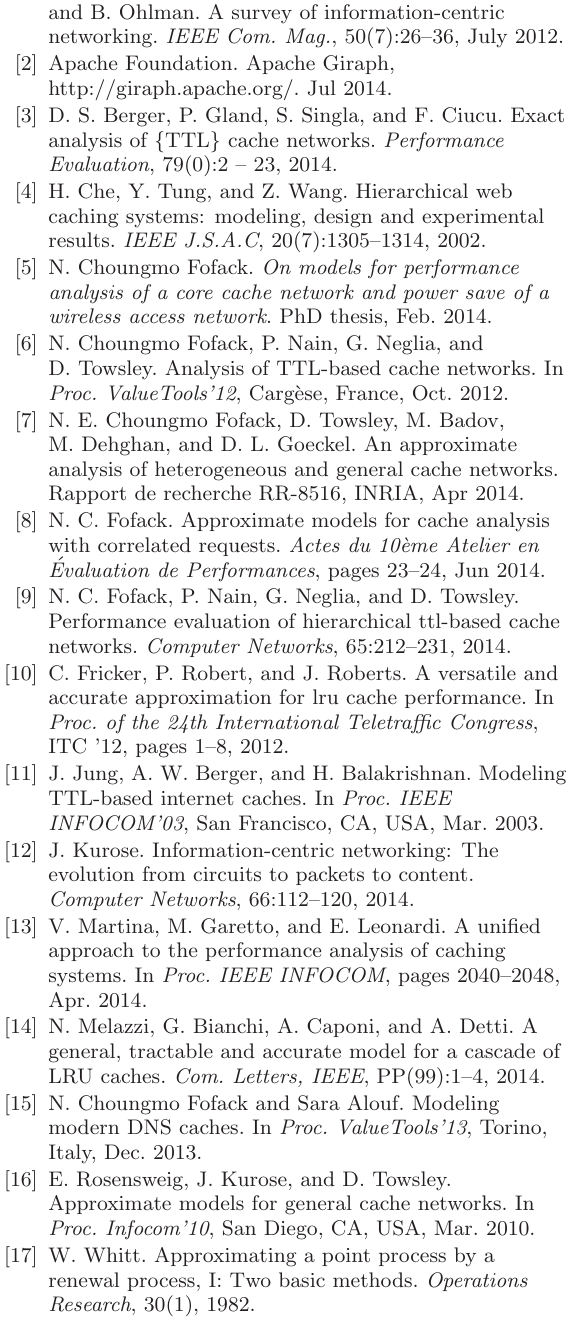
child-to-parent forwarding schema, homogeneous nodes, etc. Moreover, we showed the existence of Little’s Law -like